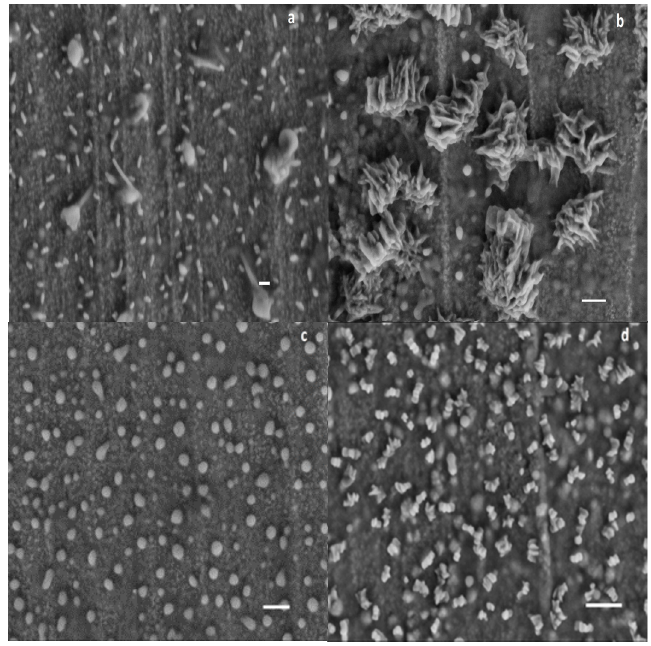
Figure 9. SEM images of the mPEG-maleic rosin aggregates at various temperatures. The deposited temperatures include: ( a ) 40 °C; ( b ) 60 °C; ( c ) 80 °C; and ( d ) 85 °C. Scale bars: ( a ) 100 nm; ( b , c ) 200 nm; and ( d ) 300 nm.